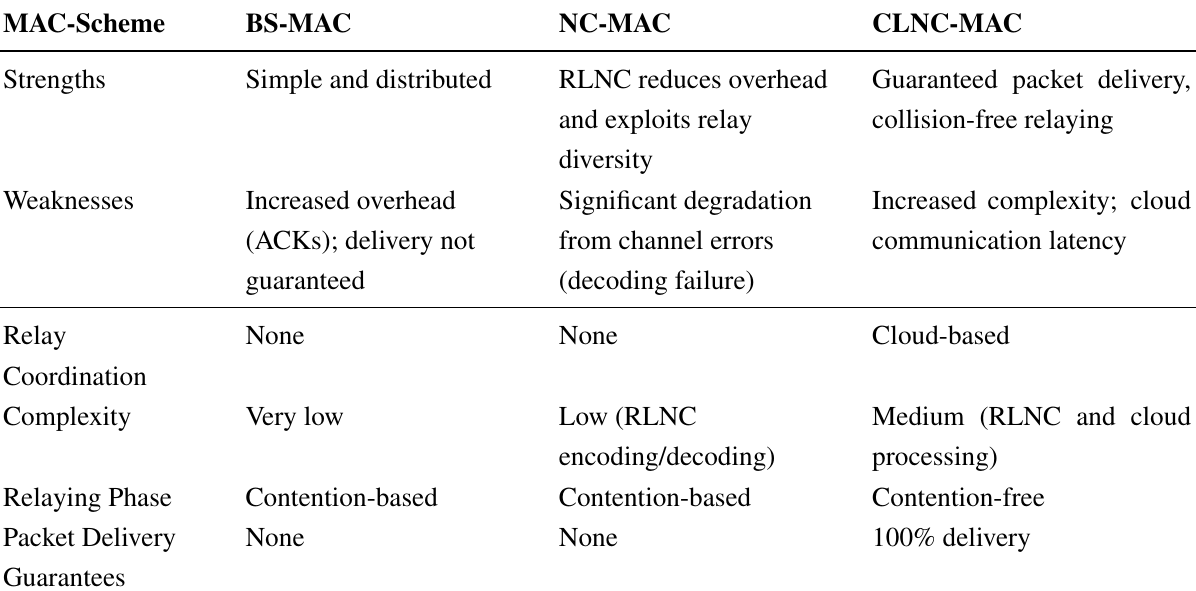
Table 1. Comparison of the three MAC